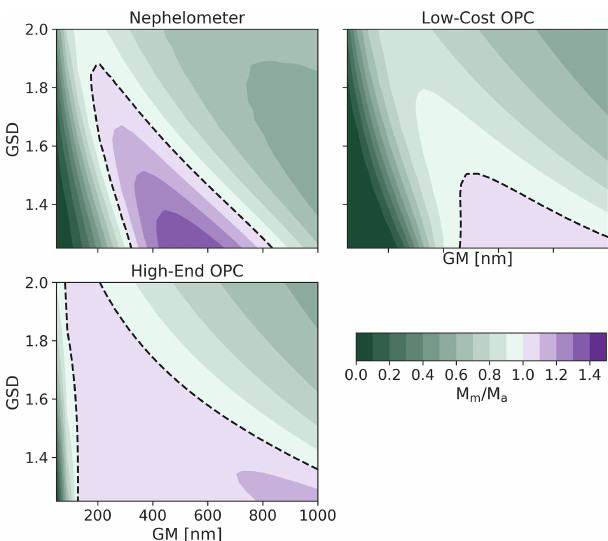
Figure 5. Mass concentration accuracy ( M m /M a ) of OPSs for a range of particle size distributions (PSDs). Accuracy is shown for all combinations of PSDs with number-weighted geometric mean diameters (GMs) between 100 and 1000nm and geometric stan- dard deviations (GSDs) between 1.2 and 2.0. Perturbations in the PSD can lead to large errors for nephelometers and optical parti- cle counters with high minimum particle size cutoffs. All results are shown for ammonium sulfate particles; the OPCs were cali- brated with PSLs, and the nephelometer was calibrated with ammo- nium sulfate ( N = 1 × 10 4 cm − 3 , GM = 400nm, and GSD = 1.5). A black dashed line indicates the 1:1 line, where M m /M a =